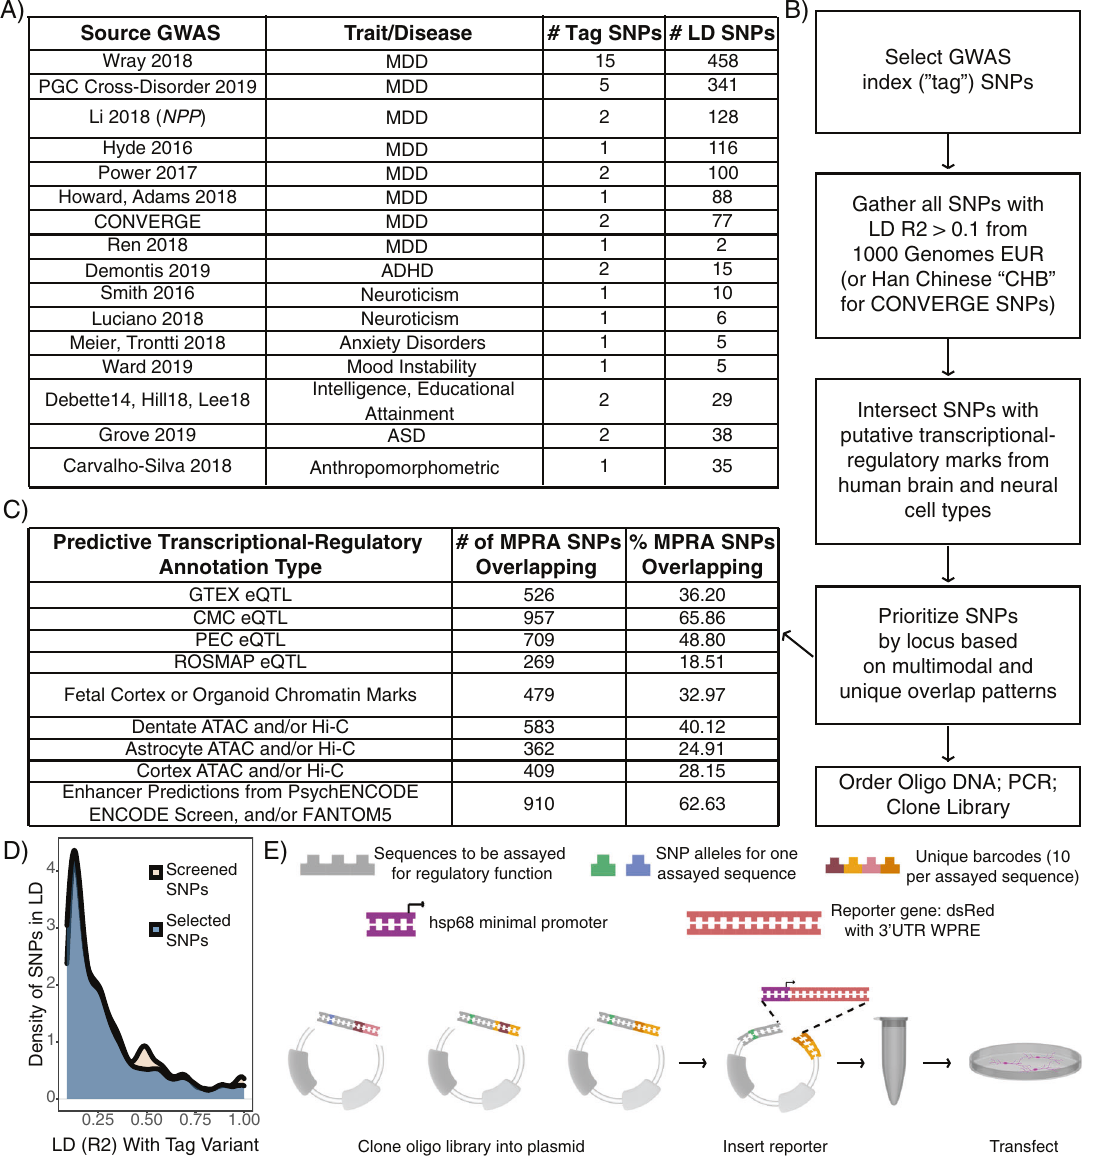
Fig. 1 Design of an MPRA library to identify candidate functional SNPs in MDD loci. A Table of GWAS studies and number of loci covered in the MPRA library. B Flow chart of design and prioritization process. C Brain and neural transcriptional-regulatory predictive annotation overlap with SNPs included in MPRA library. Fraction and number of SNPs in designed MPRA library intersecting each transcriptional-regulatory predictive annotation type. D The manual prioritization process was not LD biased. The subset of prioritized SNPs are spread over LD space similarly to the full set of screened SNPs. E Schematic of library construction and delivery. Panel adapted from